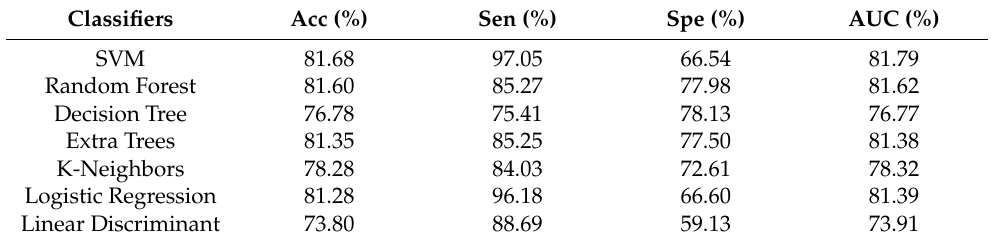
Table 6. Performance of each classifier with the selected features in the experiment with event